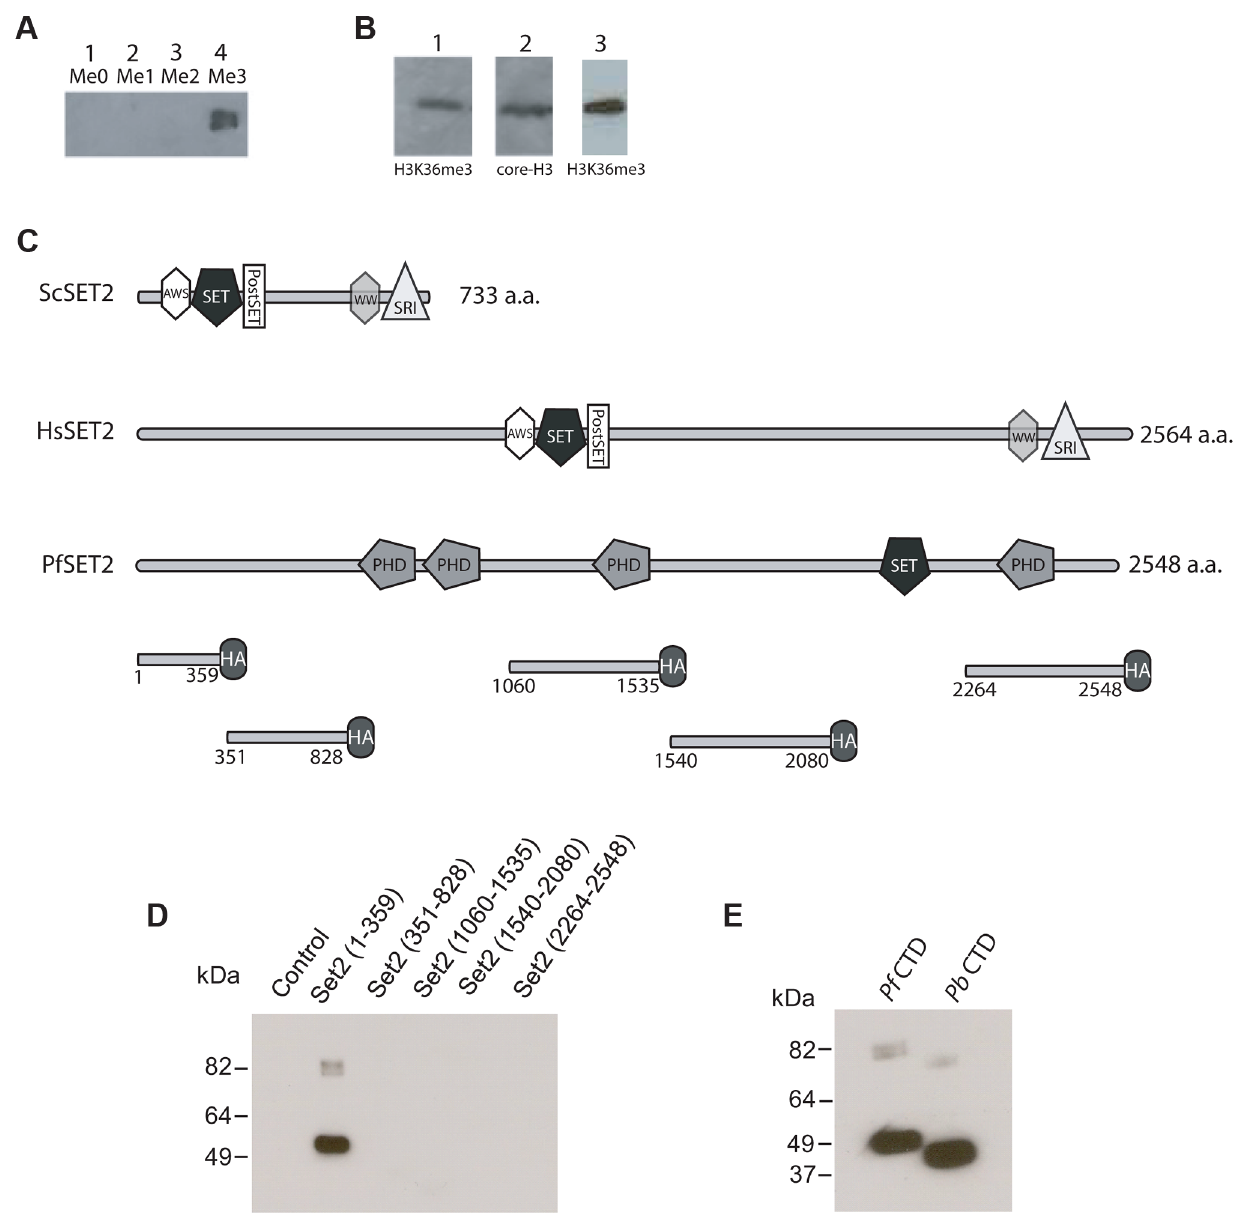
Figure 2. Detection of H3K36me3 in chromatin from P.falciparum and identification of the Rpb1binding region of PfSET2. (A) Slot blots of the synthetic peptide sequence RKSAPISAGIKKPHRYRPGT. This sequence includes K36 of histone H3 of P. falciparum (underlined). Lane 1, unmethylated peptide. Lane 2, peptide synthesized with a mono-methyl group at the K36 position. Lane 3, peptide synthesized with a di-methyl group at the K36 position. Lane 4, peptide synthesized with a tri-methyl group at K36 position. All lanes included 15 m g of purified peptide. The dot blot was probed with antibodies against the tri-methylated form of the peptide and demonstrated that the antibodies are specific to the tri- methylated form. (B) Western blot of P. falciparum protein extracts taken from early trophozoites. Lane 1, blot of total parasite proteins probed with anti-H3K36me3 antibodies. Lane 2, blot of total parasite proteins probed with anti-H3-core antibodies. Both antibodies recognize bands migrating at , 18 kDa. Lane 3, blot of acid extracted histones obtained from cultured parasites and probed with anti-H3K36me3 antibodies. (C) Comparison of the architecture of SET2 orthologs from S. cerevisiae , H. sapien and P. falciparum . Note that the SET2-Rpb1-Interacting domain (SRI) is found at the C- terminal end of both the yeast and human SET2 proteins. The protein domains shown in the figure are displayed using the format derived from SMART (Simple Modular Architecture Research Tool, http://smart.embl-heidelberg.de). Below PfSET2 are displayed the portions produced as HA- tagged, recombinant proteins for use in co-immunoprecipitation assays. The numbers below each fragment represent the amino acid positions within the full-length protein. The tandem PHD domains (amino acids 829–1060) were not included because the DNA encoding the this region of the protein was unstable in the expression vector. The SET domain was also not included because the structure and function of this domain is conserved and was previously shown not to bind the CTD in yeast and human systems. (D) Co-immunoprecipitation assays used to identify the region of PfSET2 that interacts with the CTD of Rpb1. Flag-tagged fragments of the CTD of Rpb1 shown in E were incubated with bacterial lysates containing the truncates of PfSET2 shown in C. Immunoprecipitation was performed using anti-HA beads followed by SDS-PAGE and Western blotting using anti- Flag antibodies. Only the most N-terminal portion of PfSET2 (amino acids 1–359) was found to interact with the CTD of Rpb1. The control reaction consisted of an HA-tagged PHIST protein similarly incubated with the CTD of Rpb1. (E) The N-terminal region of PfSET2 also binds to Rpb1 regions